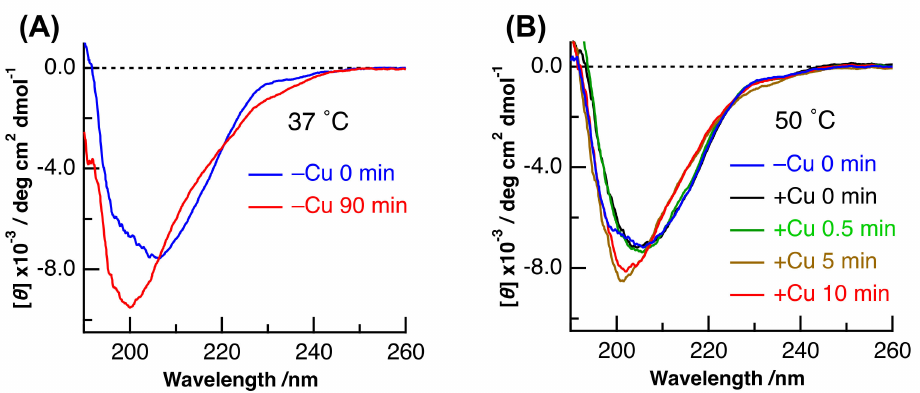
Figure 7. ( A ) CD spectra of (E,E)-H43R before and after 90 min incubation at 37 ◦ C in phosphate bu ff er. ( B ) CD spectra of (E,E)-H43R and of (Cu,E)-H43R prepared by the addition of one equivalent of Cu 2 + to (E,E)-H43R at di ff erent incubation times. The incubation temperature of ( B ) was 50 ◦